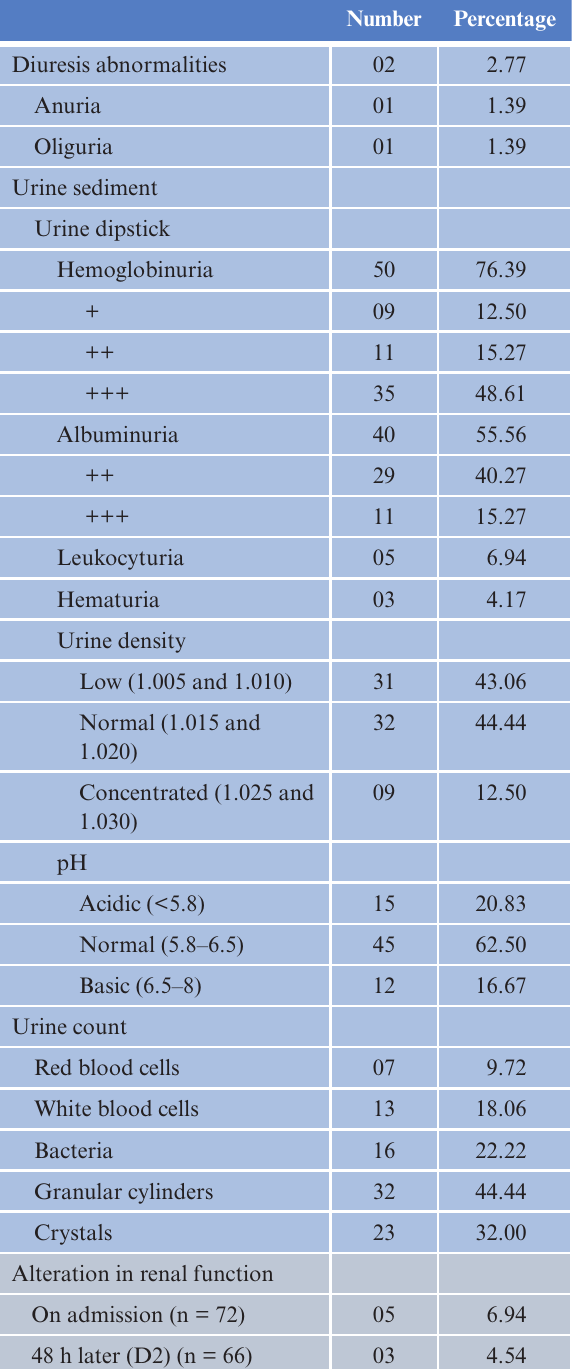
Table 1: Distribution of children with severe malaria with kidney damage according to clinical elements, urine sediment, and functional plan at Borgou DTH in 2021 (n = 72).